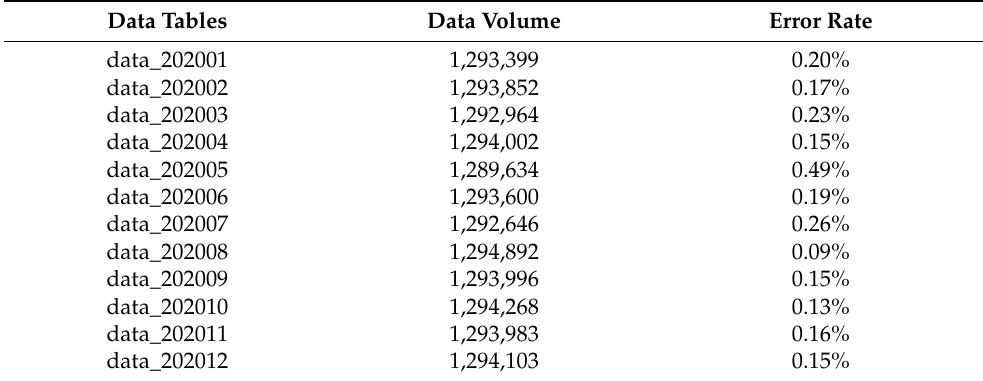
Table 2. Data volume and error rate of 12 data tables in